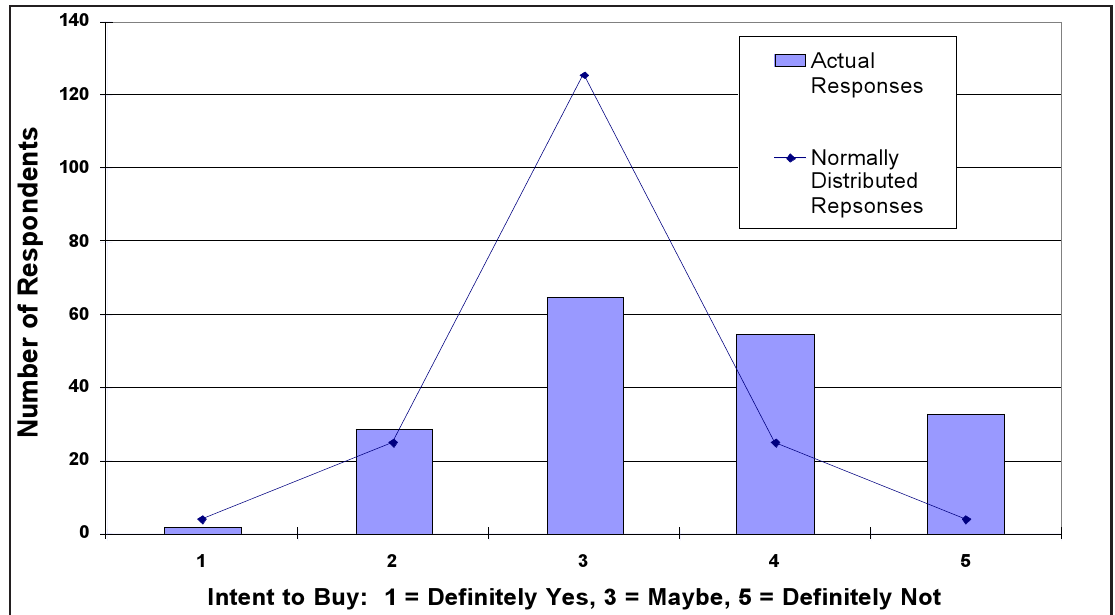
Figure 2. Comparison of Stated Intent to Buy with a Normal